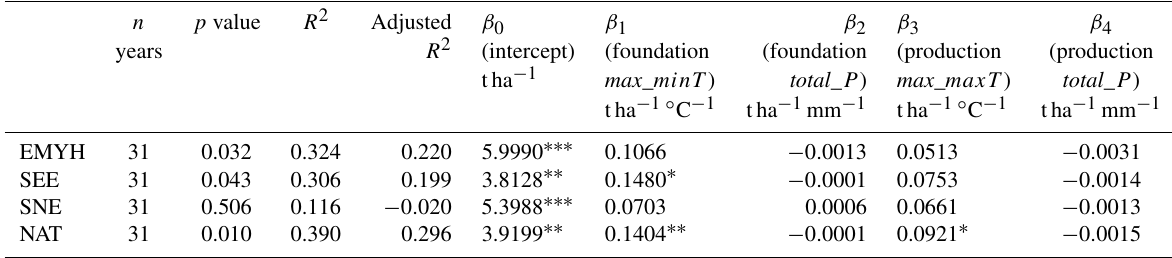
Table 4. Statistics of the multiple linear regression model (Eq. 1) for each region and nationally (historical observed data, 1990–2020). The low R 2 values can be explained by the fact that climate is only one of the mechanisms driving crop yields alongside agronomic management, as discussed in Sect. 3.3. Significance of the coefficients is indicated with stars ( ∗∗∗ indicates p < 0 . 01, ∗∗ p < 0 . 05, ∗ p < 0 . 10). We use these model fits to drive climate-based projections of future crop yields using the UKCP Local ensemble simulations (Fig. 6), assuming no future changes in agronomic management practices. The predictions issued by the regional models are similar to those issued by the national model (Fig.